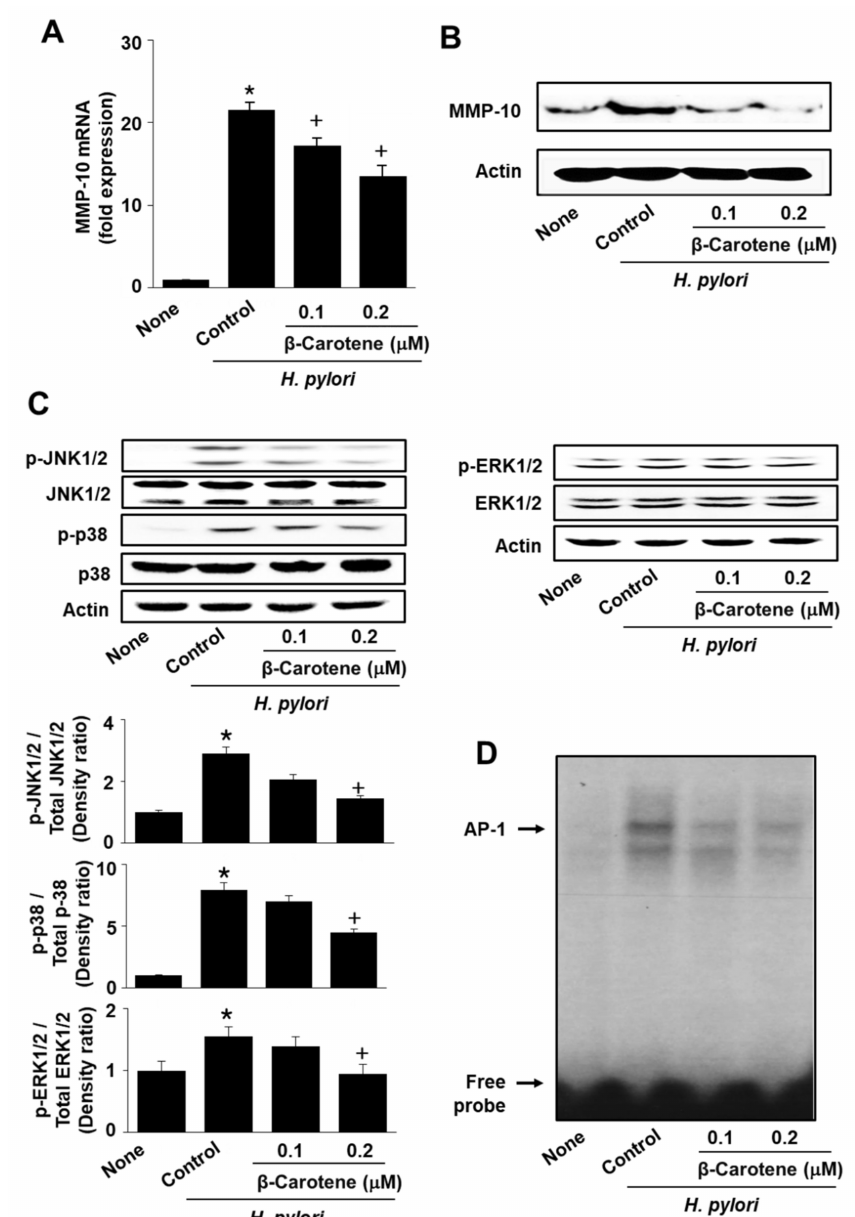
Figure 3. β -Carotene inhibits H. pylori -induced activation of MAPKs and AP-1, and expression of MMP-10 in AGS cells. Cells were pretreated with the indicated concentrations of β -carotene for 2 h and then infected with H. pylori for 24 h ( A , B ), 1 h ( C , left panel), 30 min ( C , right panel), and 1 h ( D ). ( A ) MMP-10 mRNA expression was analyzed by real-time PCR and normalized to β -actin mRNA. All data are shown as the mean ± S.E. of three independent experiments. * p < 0.05 vs. none (cells without any treatment or infection); + p < 0.05 vs. control (cells with H. pylori infection alone). ( B ) The level of MMP-10 was determined by Western blot analysis, using actin as the loading control. ( C ) Protein levels of phosphorylated or total form of JNK1/2, p38, and ERK1/2 were determined by Western blot analysis. Actin served as a loading control (upper panel). Lower panel: The densitometry data represent means ± S.E. from three immunoblots and are shown as relative density of phosphorylated protein band normalized to total form of protein level. * p < 0.05 vs. none (cells without any treatment or infection); + p < 0.05 vs. control (cells with H. pylori infection alone). ( D ) The DNA binding activity of AP-1 was measured by an electrophoretic mobility shift assay